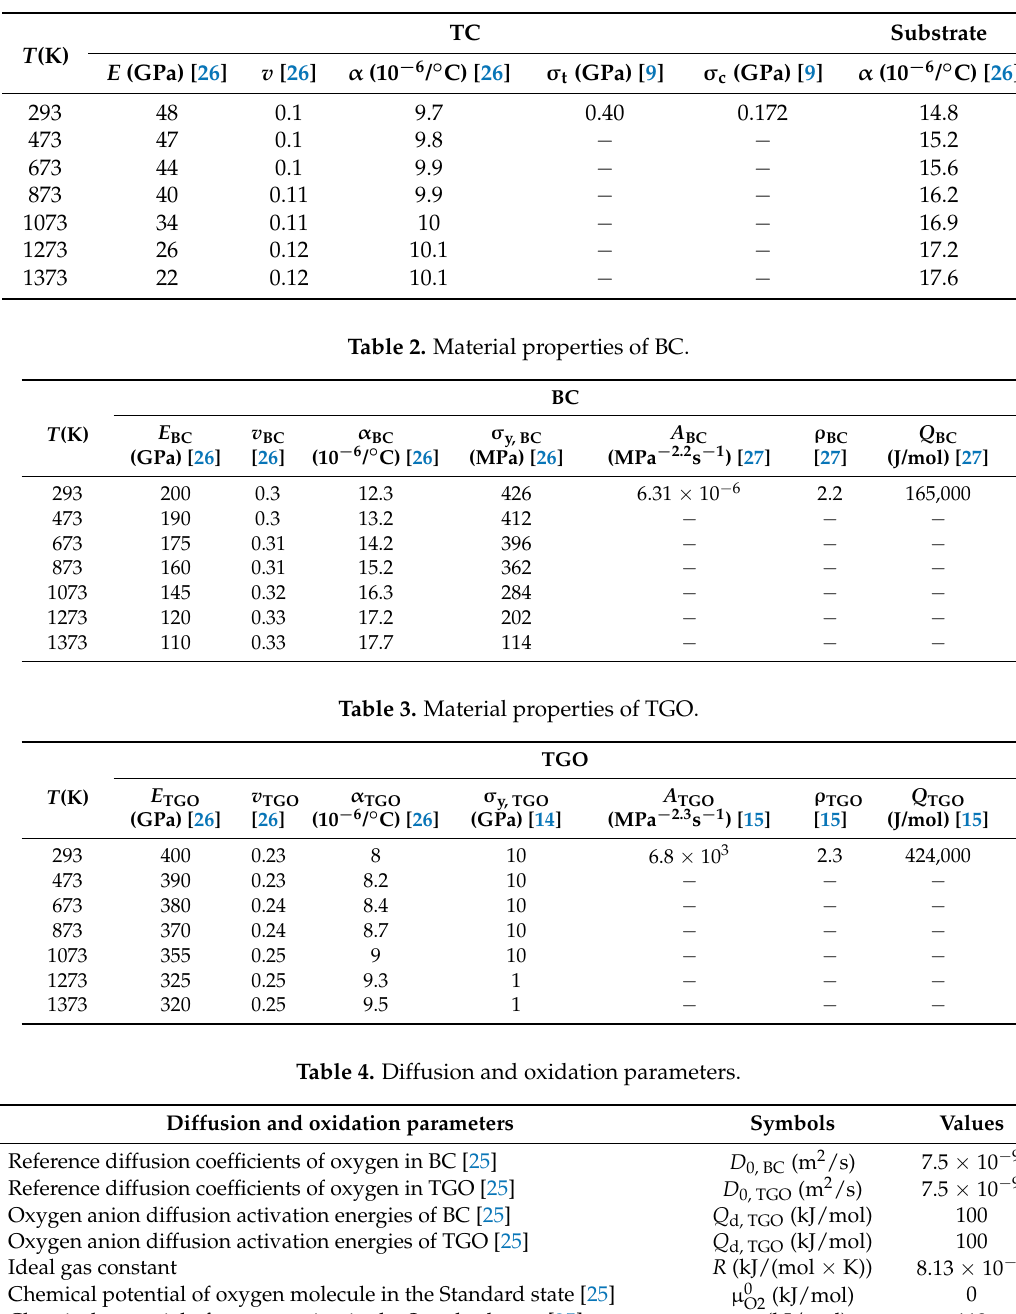
Table 1. Temperature dependent parameters of TC and substrate.